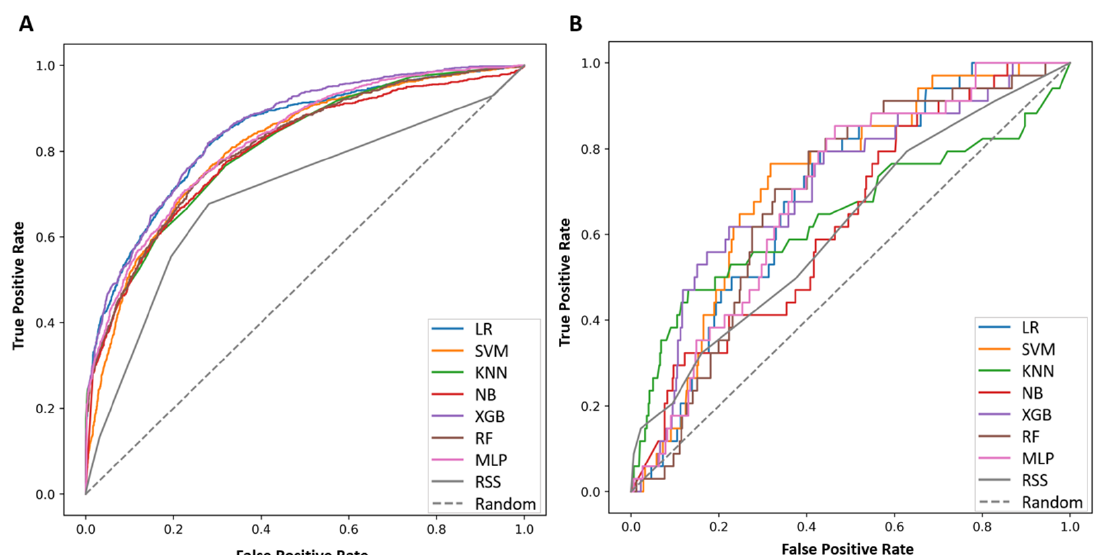
Figure 3. The area of the receiver operating characteristics for prediction of non-curative resection after endoscopic submucosal dissection. ( A ) Internal data set, ( B ) External data set. Abbreviation: RSS, risk-scoring system; LR, logistic regression; SVM, support vector machine; KNN, k-nearest neighbors; NB, naive bayes; XGB, extreme gradient boosting; RF, random forest; MLP, multilayer perceptron. Table 3. Performance of the non-curative resection prediction model for the seven machine-learning models used in this